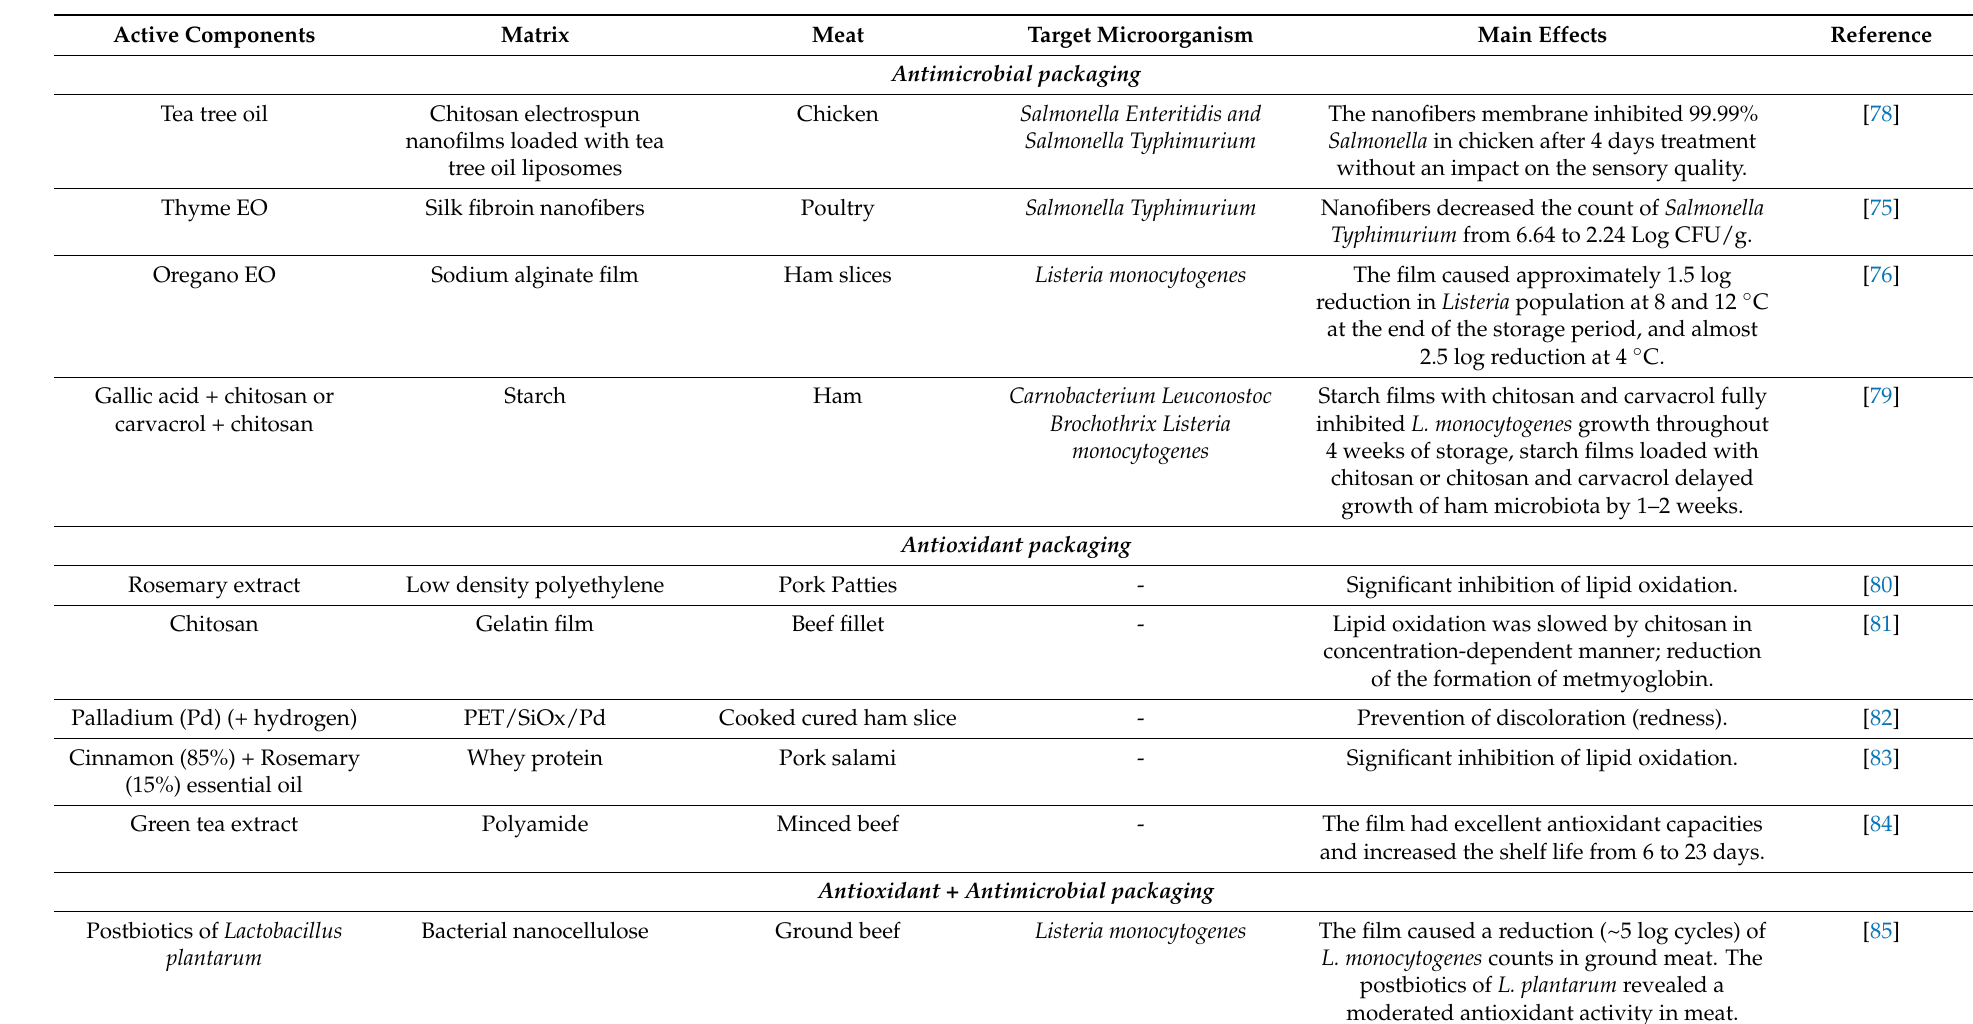
Table 2. Progress in active packaging with antimicrobial and antioxidant functions and their meat